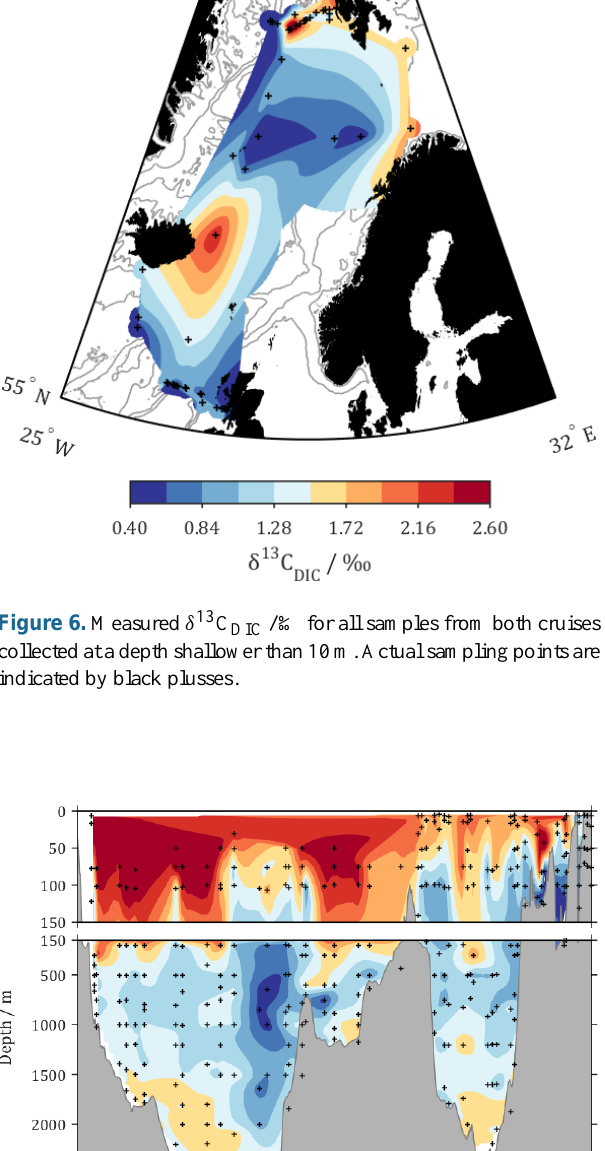
Table 4. Mean absolute differences between sampling duplicates. The “sample container” column indicates whether the duplicates were collected in the same type of container as each other, or differ- ent containers (i.e. one in a vial, one in a bottle).